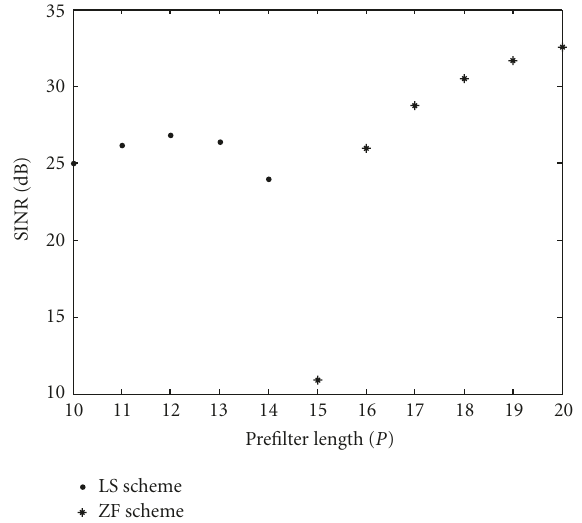
Figure 6: SINR performance of the ZF and LS schemes with respect to prefilter